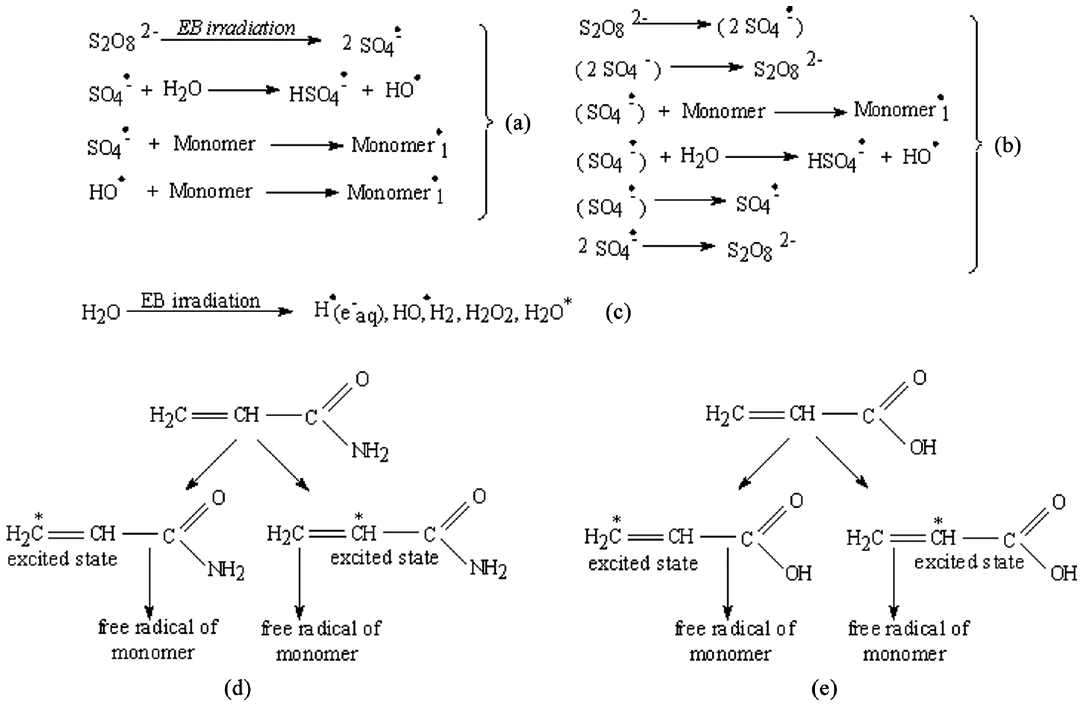
Figure 10. Possible mechanism for obtaining radicals by electron beam irradiation: (a) and (b) from initiator, potassium persulphate; (c) from water; (d) from acrylamide; (e) from acrylic